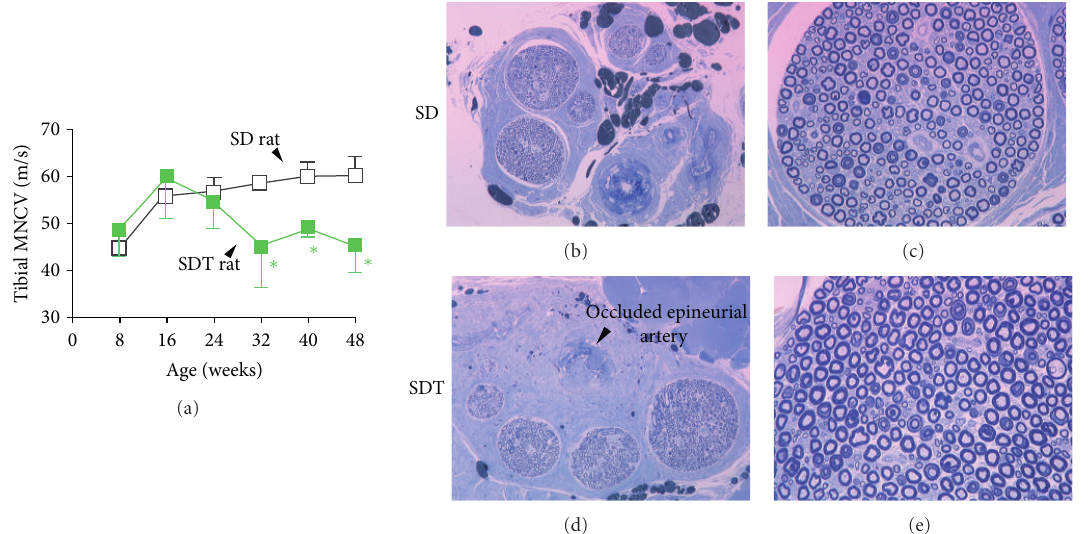
20 m). In the ) were observed (h) (HE stain, bar 50 m). = 𝜇𝜇 ∗ = 𝜇𝜇